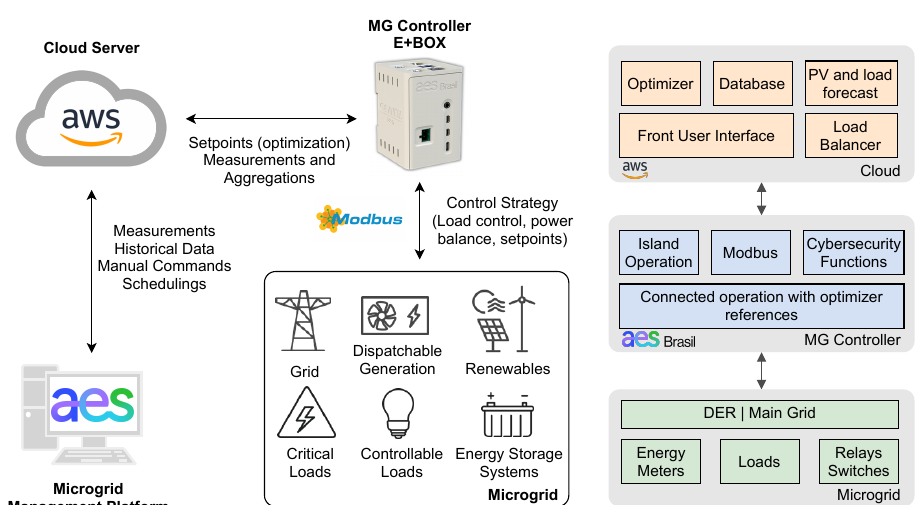
Figure 1. Product solution diagram for MG control and